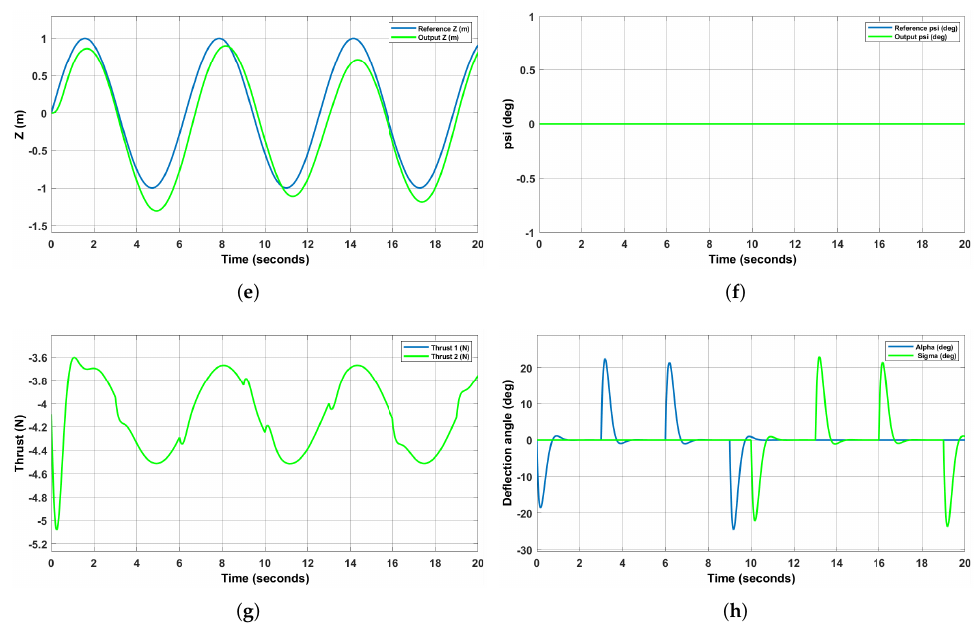
Figure 21. Responses for second simulation: ( a ) X response; ( b ) φ response; ( c ) Y response; ( d ) θ response; ( e ) Z response; ( f ) ψ response; ( g ) thrust response; ( h ) deflection angles response.